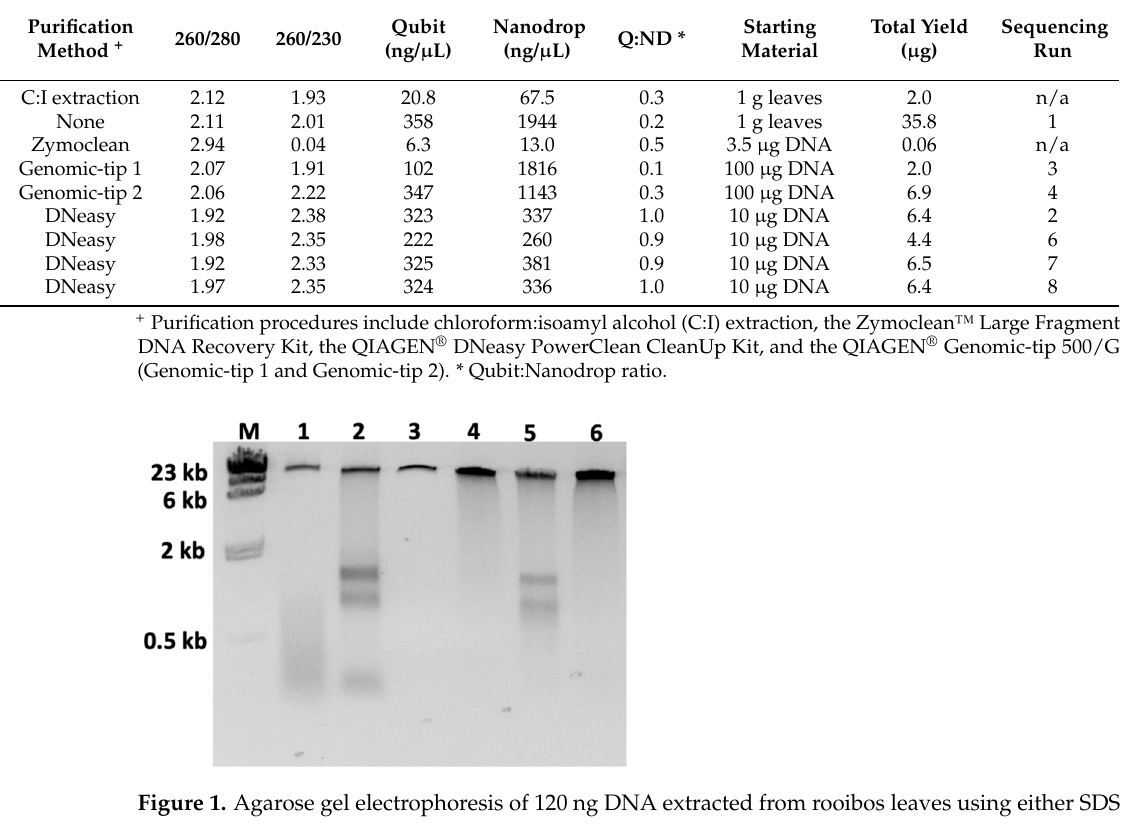
Table 1. Yields and quality metrics for rooibos DNA samples from two rooibos plants generated using various DNA extraction and purification procedures.